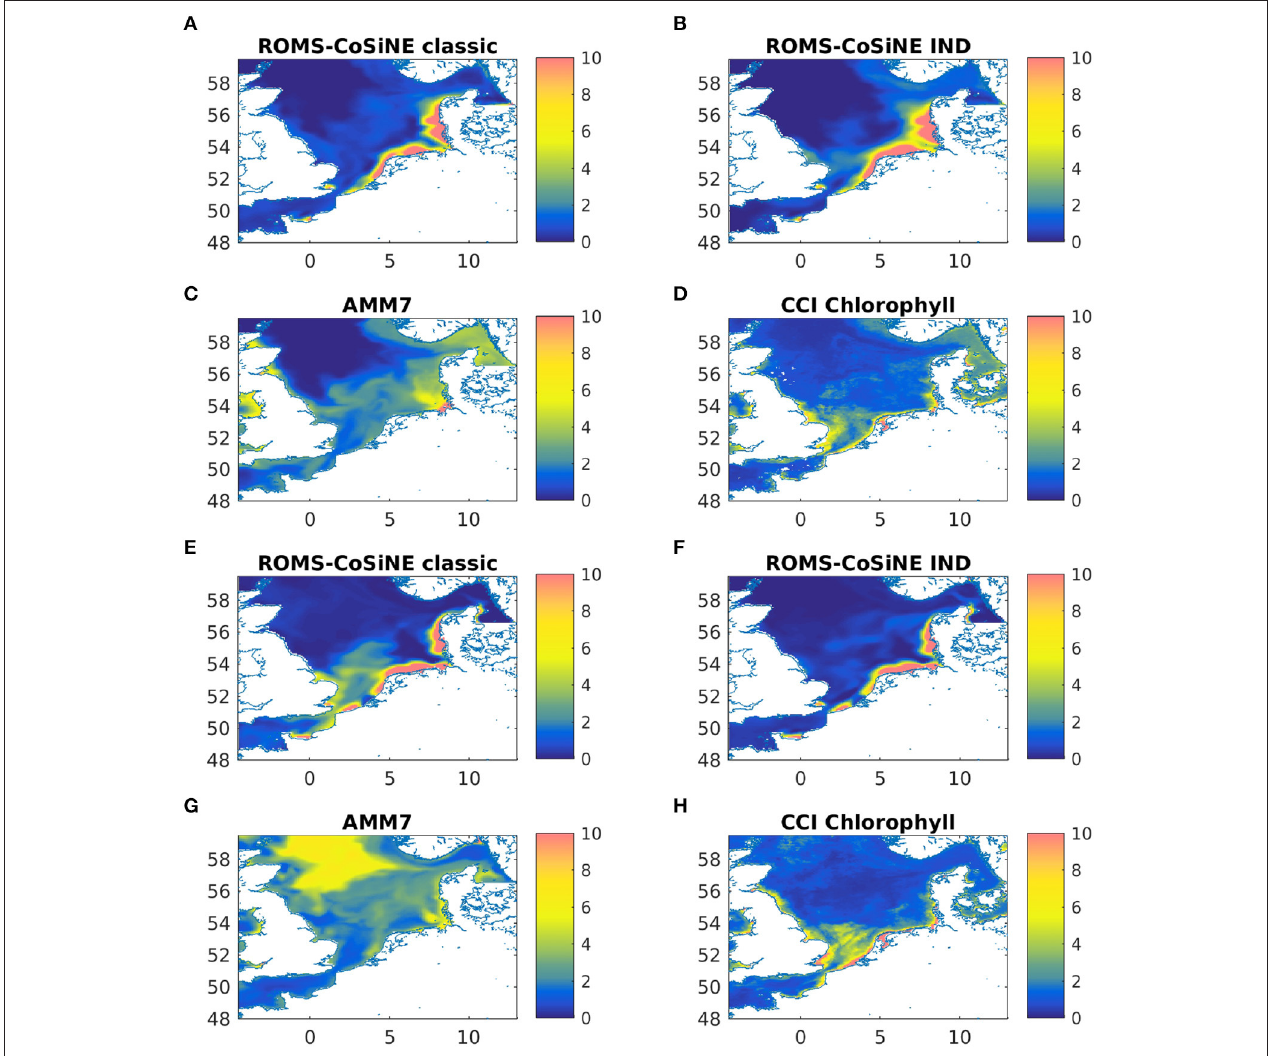
FIGURE 5 | Monthly means of chlorophyll-a [ mgChl − am − 3 ] for ROMS-CoSine in the classic formulation (A,E) , and the IND formulation (B,F) , as well as AMM7 (C,G) , and CCI data (D,H) for March 2013 (A–D) and May 2013 (E–H)